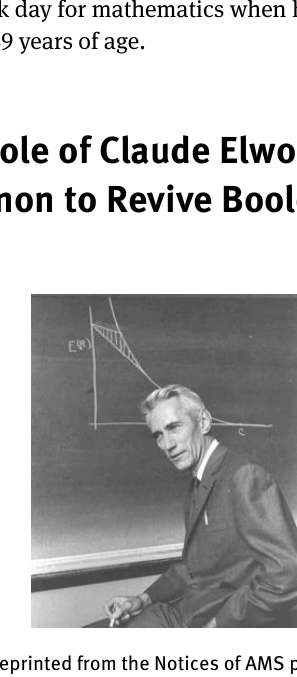
Fig. 2. Picture reprinted from the Notices of AMS paper by Golomb et al., available at http://www.ams.org/notices/200201/ feashannon.pdf (courtesy of the MIT